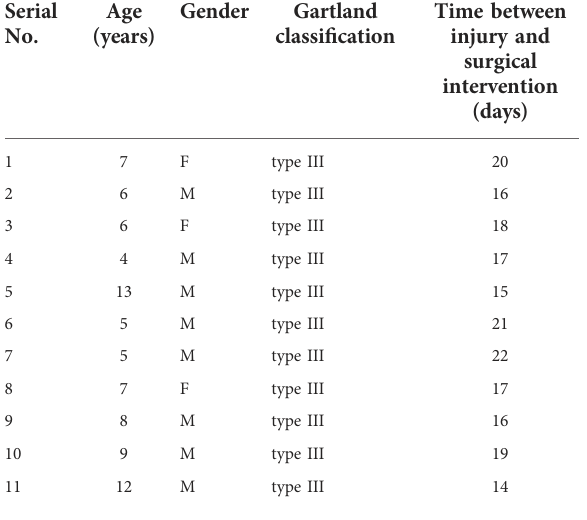
TABLE 3 Perioperative and follow-up